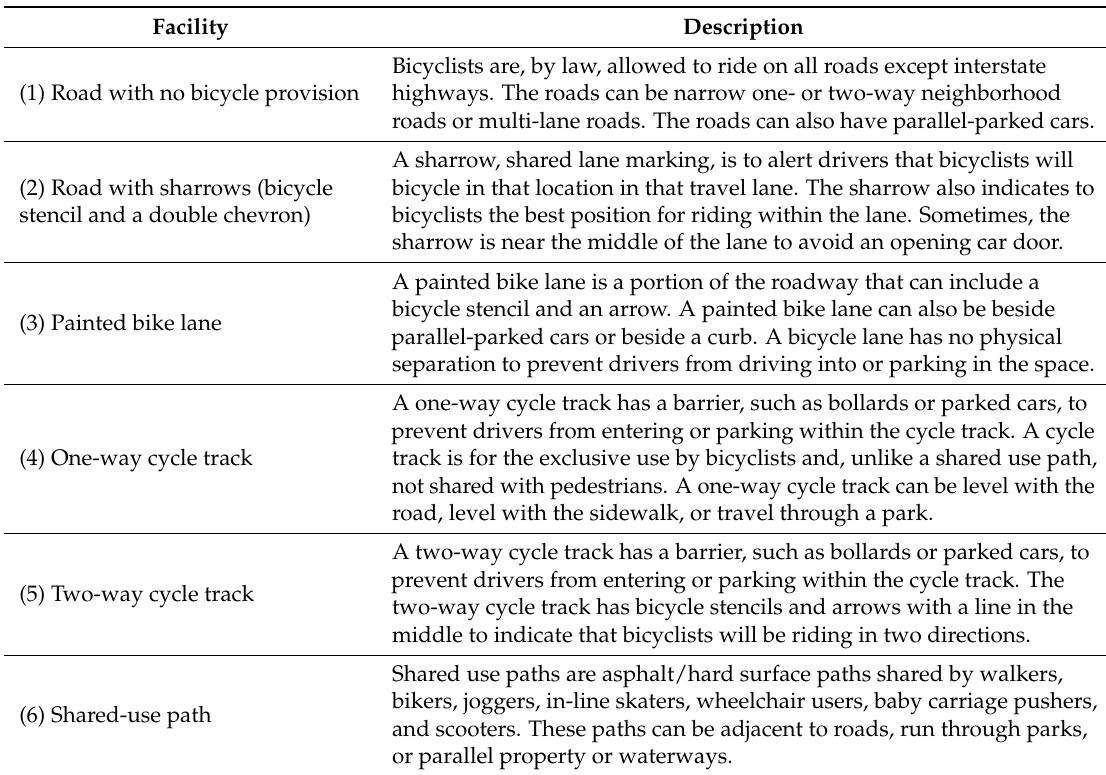
Table 1. Bicycle environments in the 32